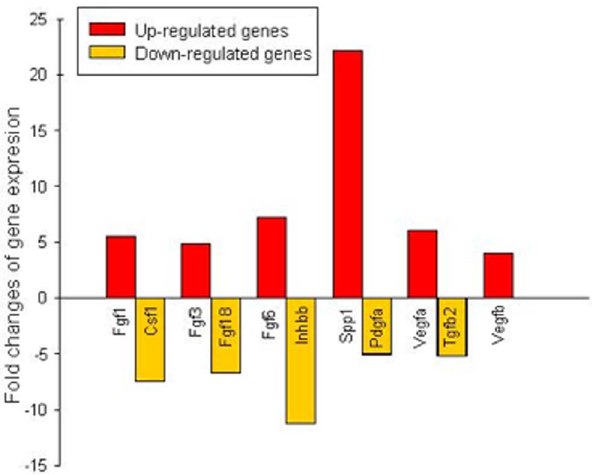
Figure 7. Supperarray profiling of 88 growth factor related genes in Sca1 + /CD31 2 cell and IGF + HGF treated Sca-1 + /CD31 2 cells. The fold differences plotted for each gene are calculated from via the DD C t method and raw data normalized to a panel of housekeeping gene.